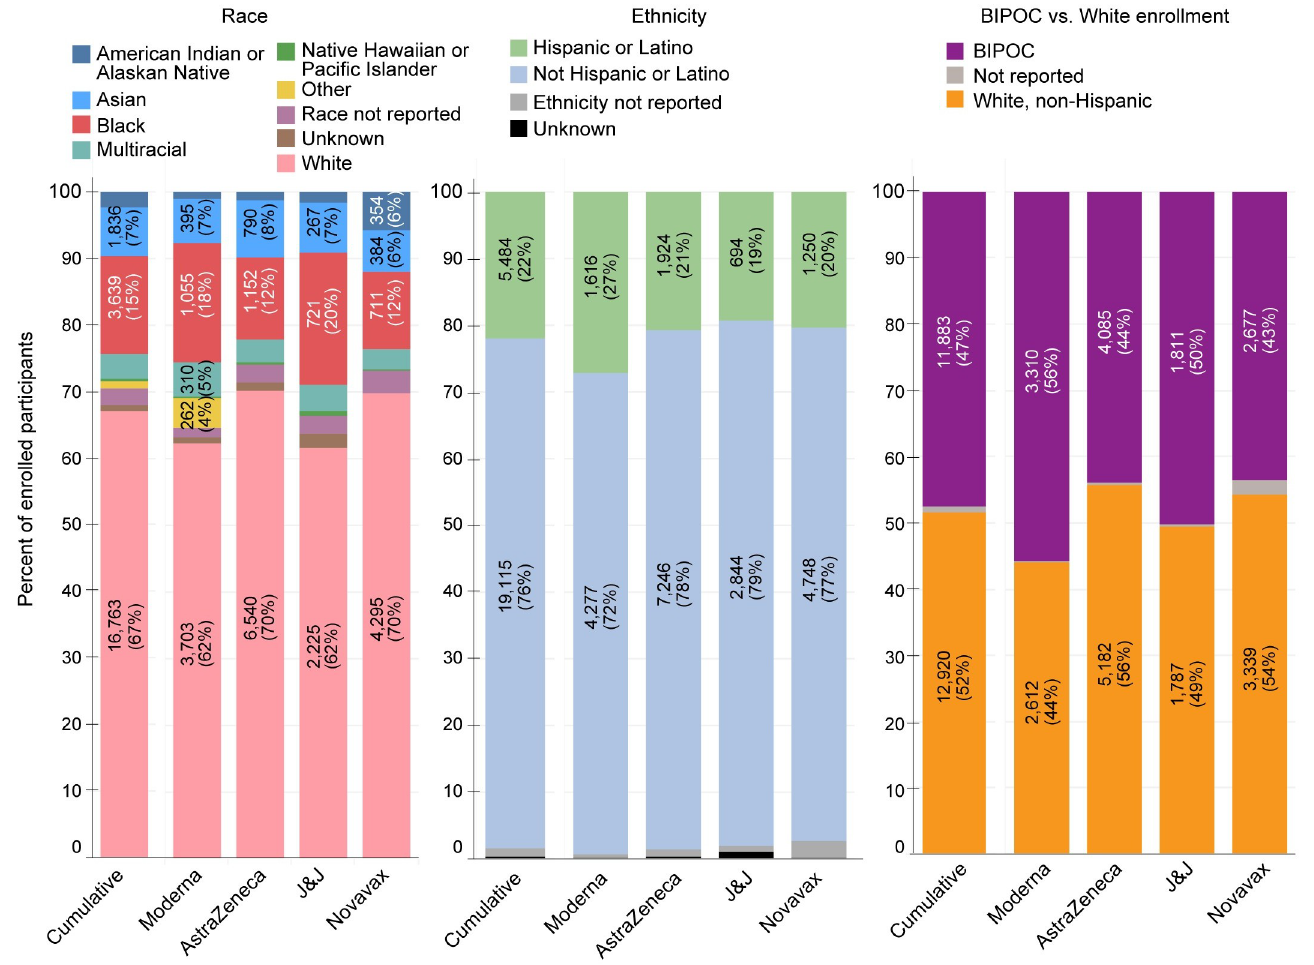
Fig 1. US diverse enrollment across the NIH-funded Moderna, AstraZeneca, J&J, and Novavax trials.